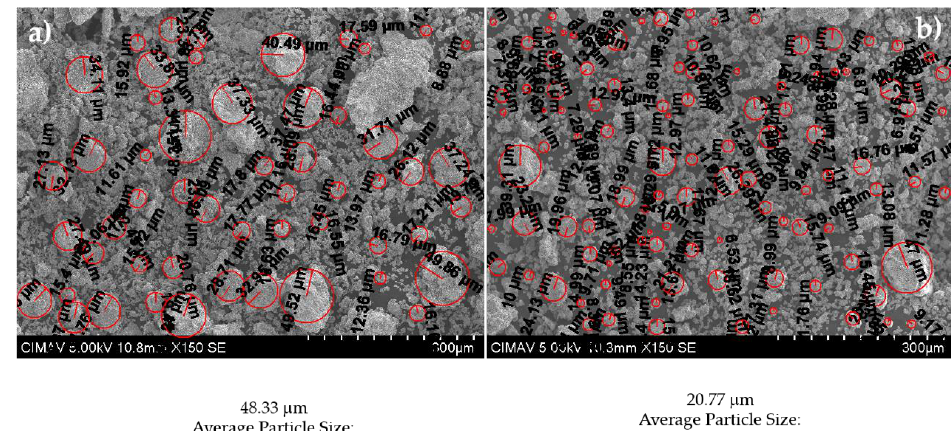
Figure 2. Secondary electron-scanning electron microscope (SE-SEM) micrographs of the Al2024-2.0 wt.% B 4 C composite milled during ( a ) 1 h and ( b ) 2 h.